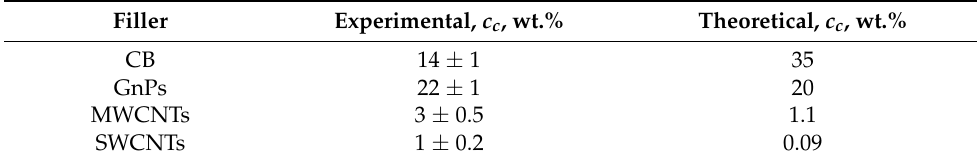
Table 2. Percolation thresholds for PP composites filled with various fillers, determined from the experimental data and the theory.